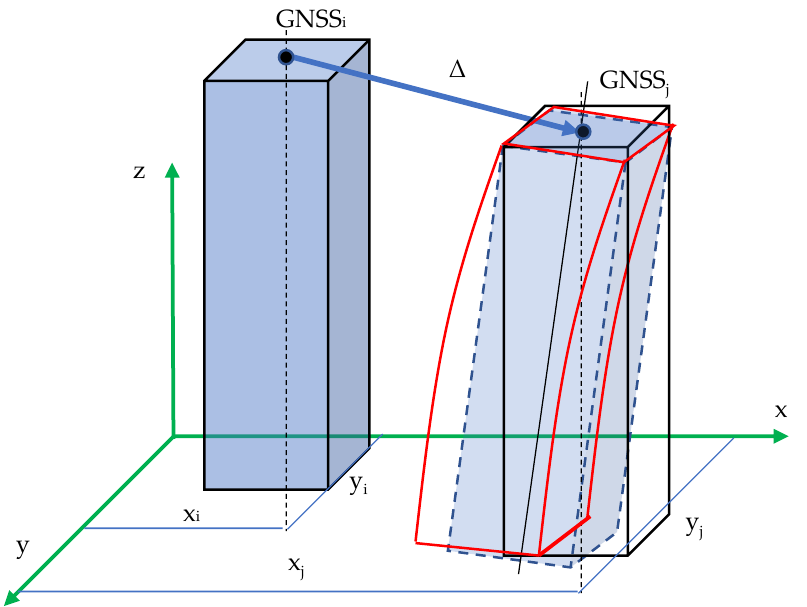
Figure 2. The structure displacement caused by either roll or bending in combination with spatial